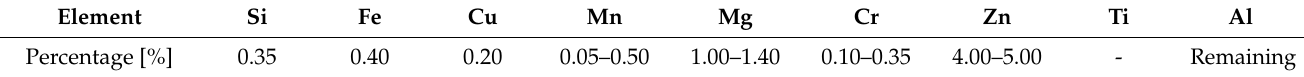
Table 3. Chemical composition of EN AW 7020